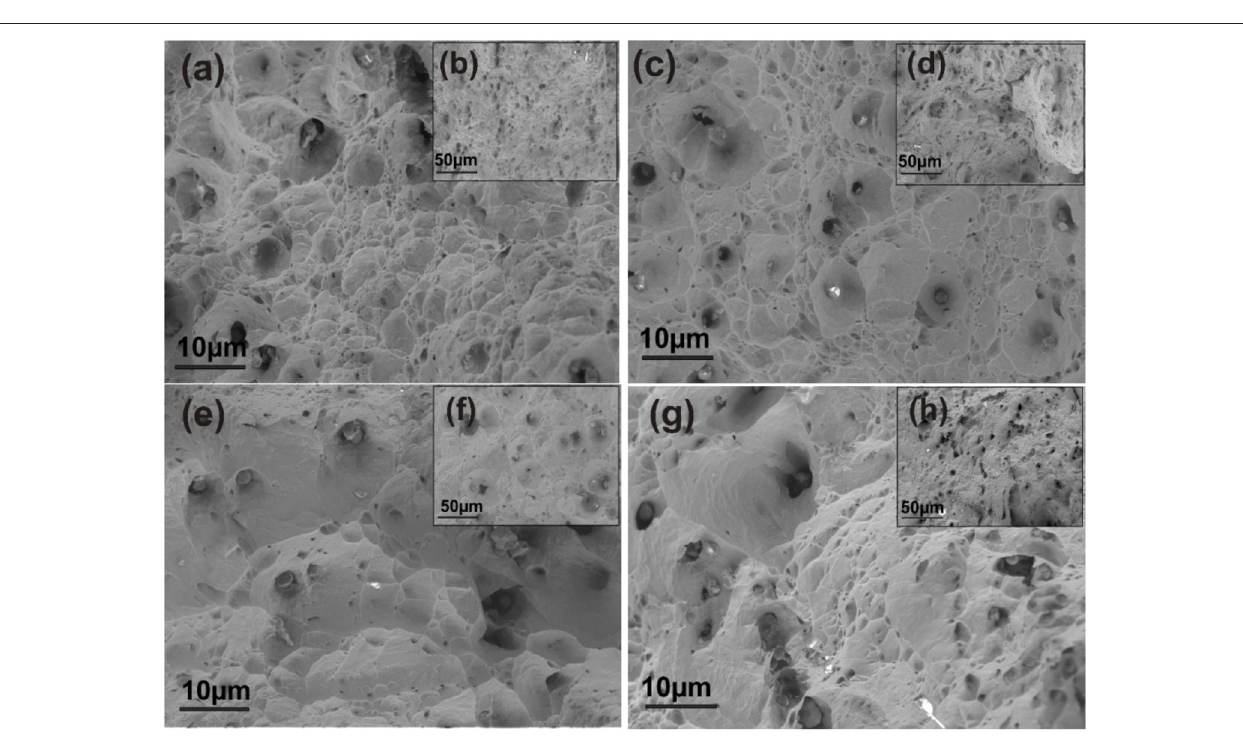
FIGURE 5 | Fracture morphologies of the dual-phase HEA samples with varying grain sizes at different strain rates after the constant strain rate tensile tests. (a,b) Fine-grained and constant strain rate of 1 × 10 − 4 s − 1 ; (c,d) Fine-grained and constant strain rate of 5 × 10 − 3 s − 1 ; (e,f) Coarse-grained and constant strain rate of 1 × 10 − 4 s − 1 ; (g,h) Coarse-grained and constant strain rate of 5 × 10 − 3 s − 1